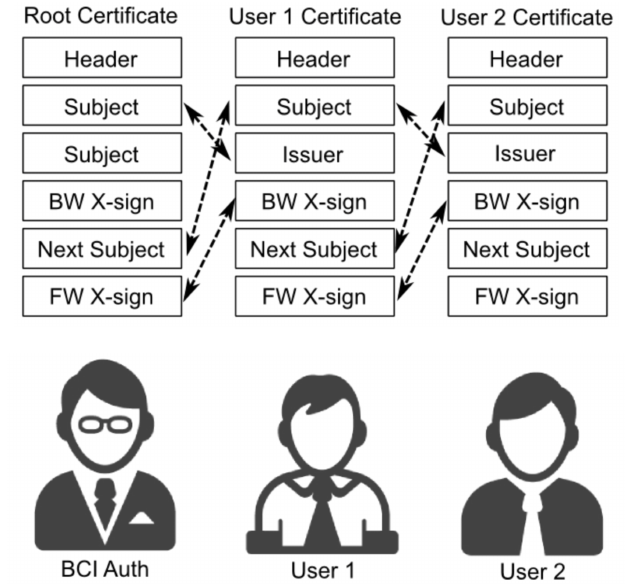
Fig. 1. Issuing of Certificates and Building an Instance of the